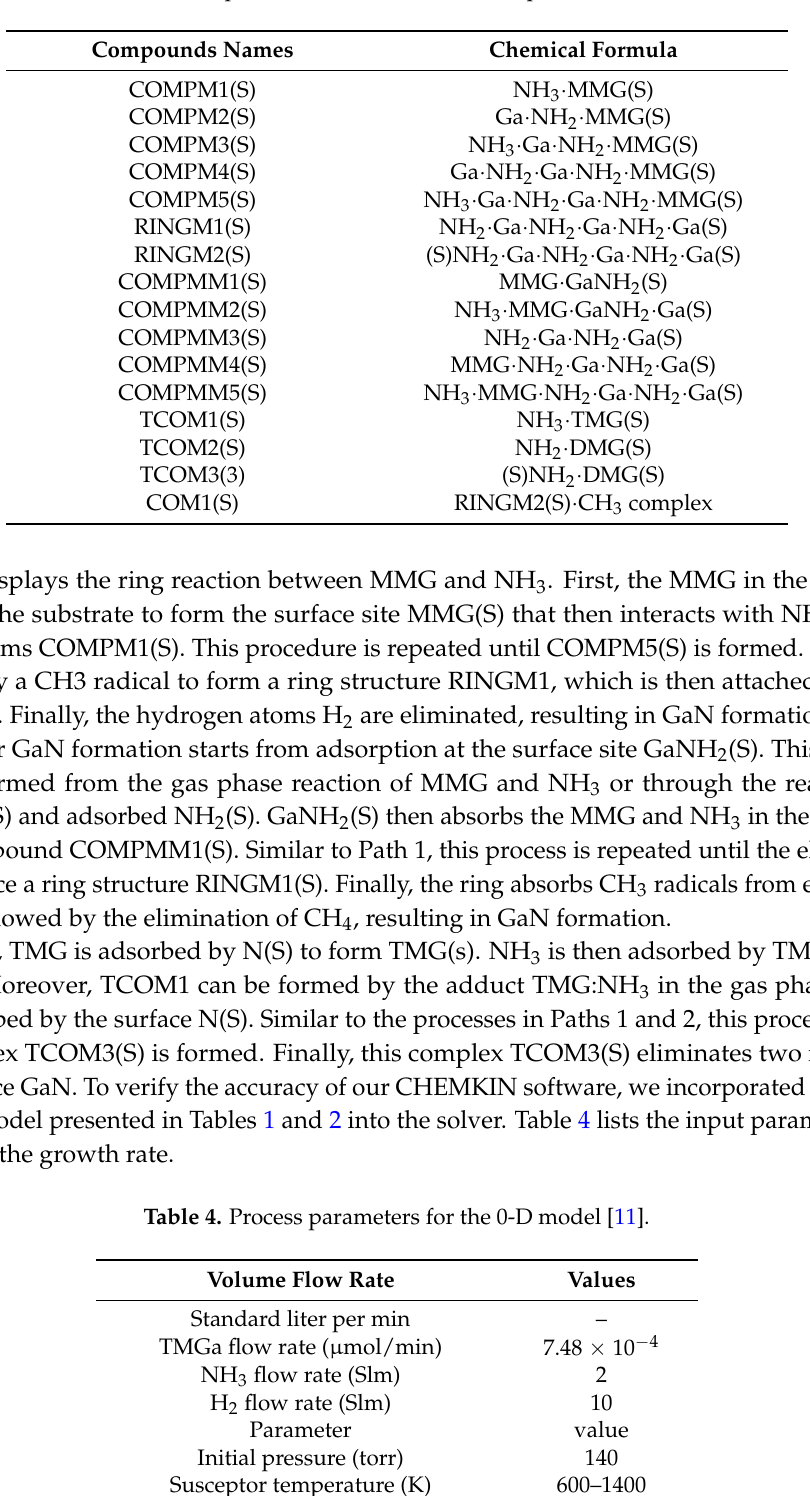
Table 3. Chemical compositions for the chemical compounds on the surface [15].